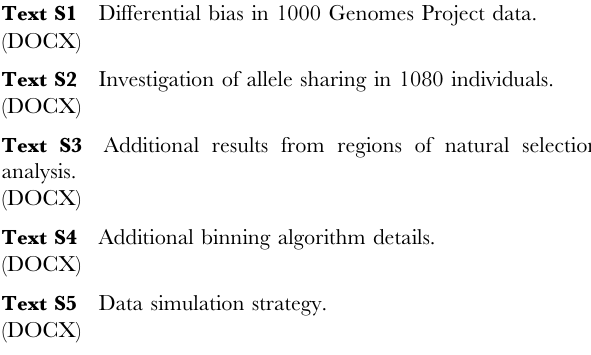
Table S6 Low frequency simulation using SimRare to assess Type I error and